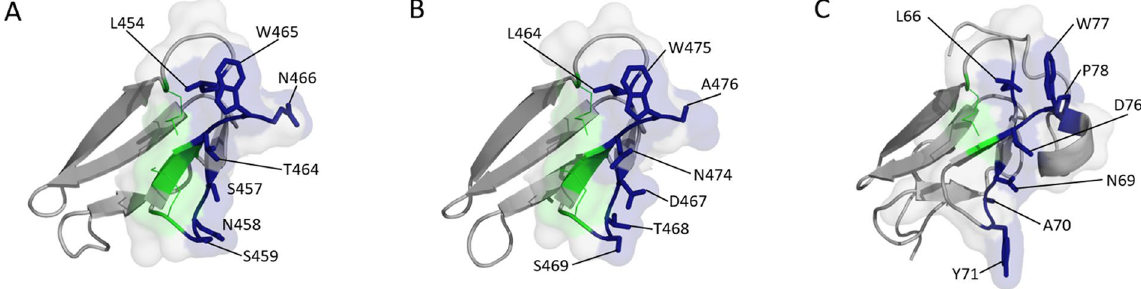
Figure 2. Structures of ChBD CHIT1-49 , AMCase (3D model) and tachycitin ( “hevein-fold” motifs are shown in transparent surface representation). ( A ) Crystal structure of ChBD CHIT1-49 (PDB ID: 5HBF). The aromatic and polar residues are represented in blue sticks (conserved disulphide bonds are represented as green lines). ( B ) 3D model of AMCase CBM14 (YASARA) built by sequence homology using the ChBD CHIT1-49 X-ray 3D structure as template. The corresponding residues shown in Fig. 2A are highlighted in blue sticks. ( C ) NMR structure of tachycitin (PDB ID: 1DQC) where corresponding residues shown in Fig. 2A are highlighted in blue